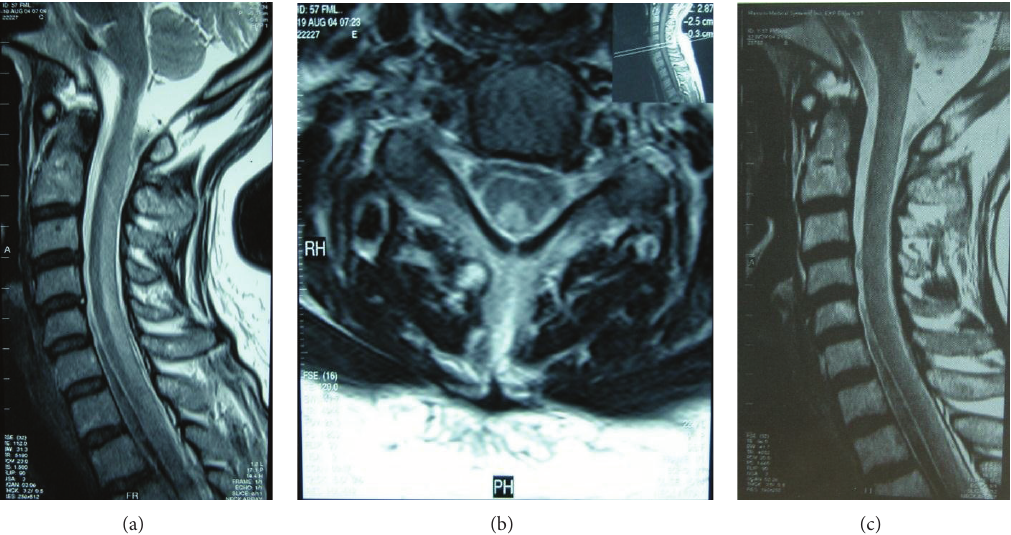
Figure 1: ((a), (b)) At the baseline sagittal and axial T2 weighted MRI study, hyperintensity of the posterior columns can be seen in the cervical cord. (c) Posttreatment sagittal T2 magnetic resonance images showed total regression of the MRI